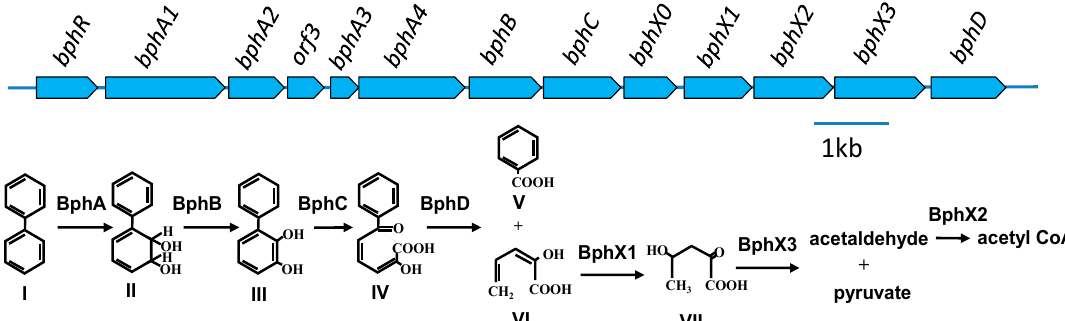
Figure 1. Catabolic pathway of the biphenyl degradation and organization of the bph gene cluster in P. furukawaii KF707. Compounds: I, biphenyl; II, 2,3-dihydroxy-4-phenylhexa-4,6-diene (dihydrodiol compound); III, 2,3-dihydroxybiphenyl; IV, 2-hydroxy-6-oxo-6-phenylhexa-2,4-dienoic acid (biphenyl meta -cleavage compound: HOPD); V, benzoic acid; VI, 2-hydroxypenta-2,4-dienoic acid; VII, 4-hydroxy-2-oxovalerate. Enzymes: BphA1-BphA2-BphA3-BphA4, biphenyl dioxygenase; BphB, dihydrodiol dehydrogenase; BphC, 2,3-dihydroxybiphenyl dioxygenase; BphX0, glutathione S -transferase; BphX1, 2-hydroxypenta-2,4-dienoate hydratase; BphX2, acetaldehyde dehydrogenase (acylating); BphX3, 4-hydoxy-2-oxovalerate aldolase; BphD, 2-hydroxy-6-oxo-6-phenylhexa-2,4-dieonic acid hydrolase. The BphR protein, belonging to the GntR family, is a transcriptional regulator involved in the expression of bphR and bphX0X1X2X3D . The function of orf3 remains unclear.